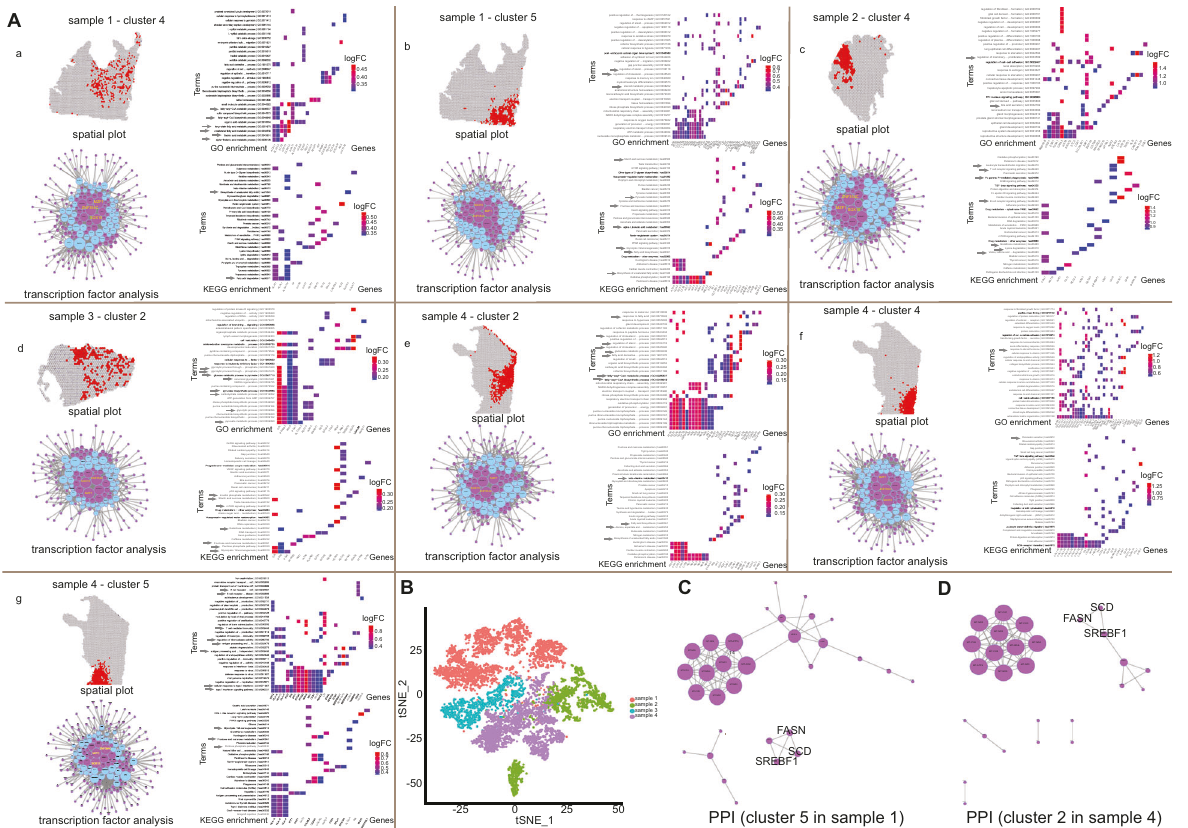
Fig. 3 Enrichment, transcription factor analysis and PPI of IMPC cluster in four samples. A Highlight spatial hierarchical plot, GO